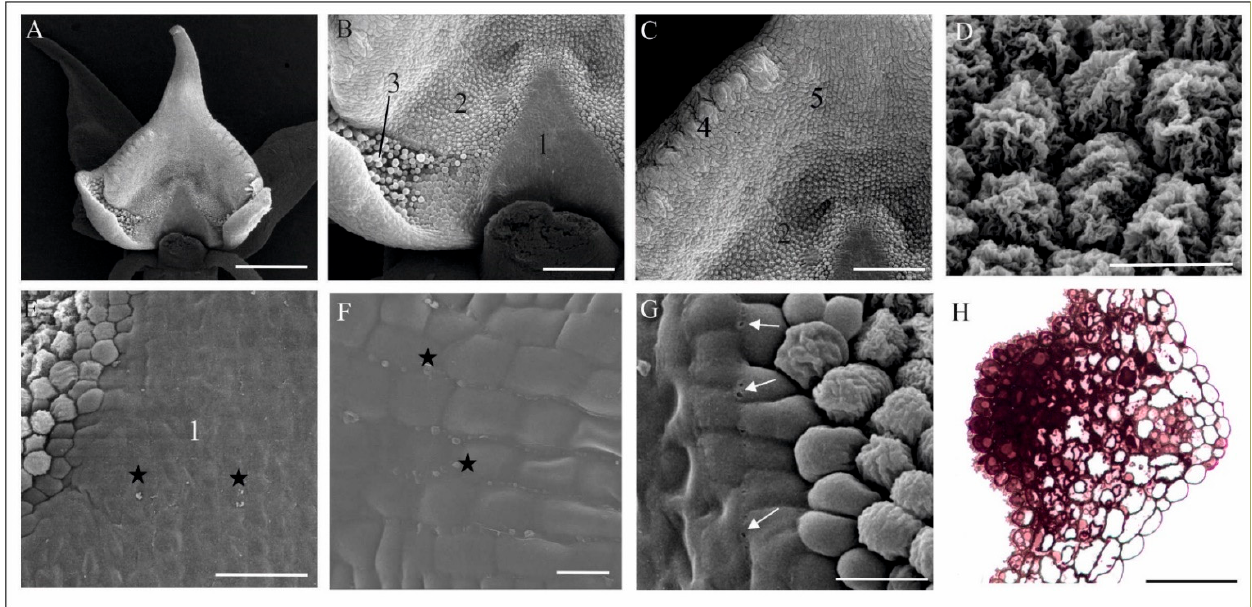
Figure 2. The micromorphology and histochemistry of the M. monophyllos labellum (SEM, LM). ( A , B ) Labellum—a frontal view with the folded margins and epidermal cells differentiated in terms of the cuticle structure and secretory function: (1) a triangle-shaped area with a smooth surface located behind the gynostemium; (2) cells of a strongly undulated cuticle; (3) glandular trichomes in the lateral, folded margins of the labellum; ( C ) upper parts of the labellum with distinct areas: (4) the bulging cells along the edges of the labellum, (5) the cells of the central part of the labellum; ( D ) details of the inner part of the labellum (2), made of cells with the strongly undulated cuticle; ( E – G ) details of triangle-shaped area (1); ( E , F ) smooth surface (1) formed by thick cuticular coat covering the cells, with residues of secreted substances (asterisk); ( G ) pores (arrows) on the edge of the waxy coat; ( H ) lipid concentration in epidermal and subepidermal cells of the inner part of the labellum (1) (semisection treated with SBB). Scale bars: 500, 200, 200, 20, 50, 10, 20, 50 µm.